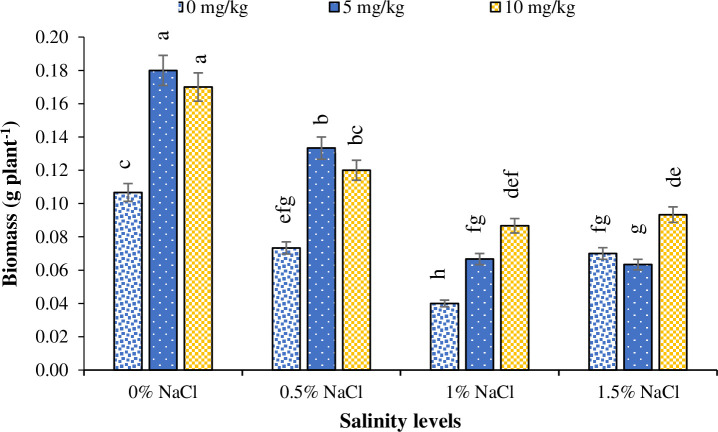
The influence of different zinc levels on dry biomass production of Basil (Ocimum basilicum L.) grown under different NaCl salinity levels.The vertical bars are means ± standard errors. Any two means having different letters are statistically different from each other (p < 0.05).